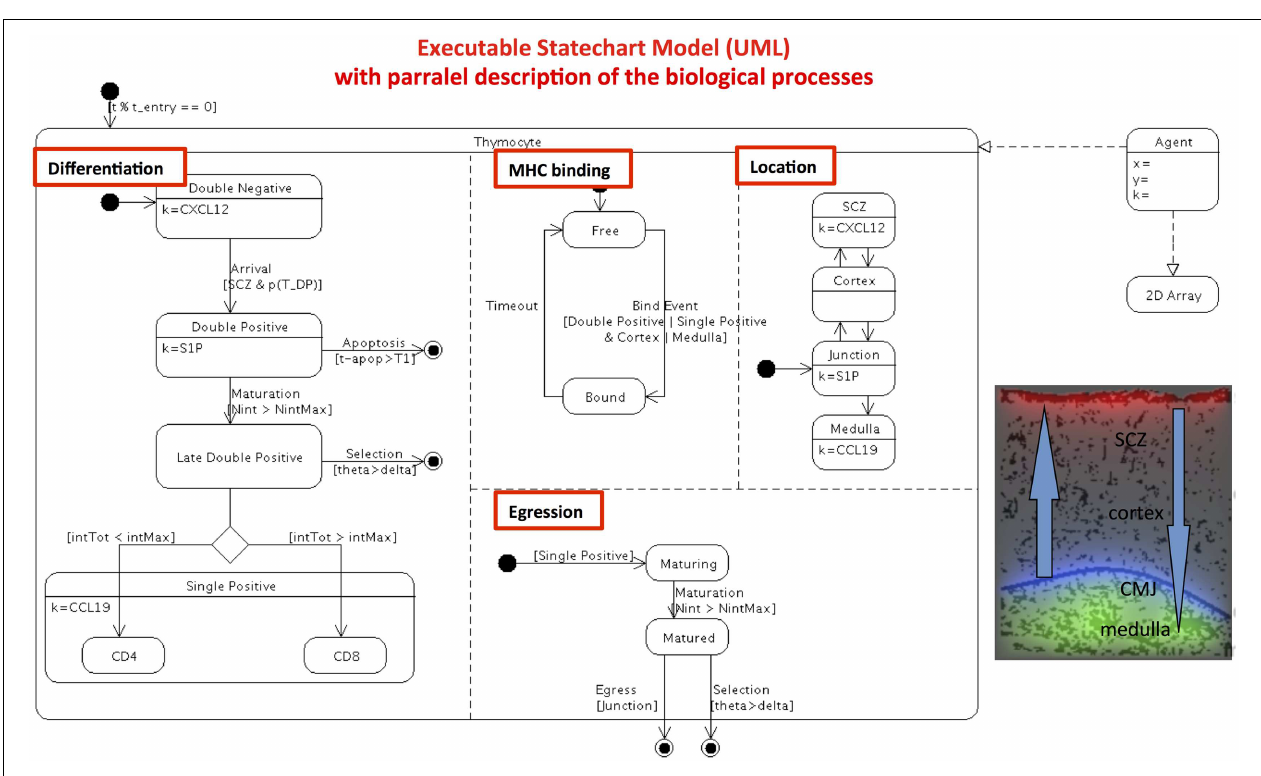
represented by their differentiation from DN to SP stage, sequential binding event ofTCR/MHC peptide on epithelial cells, thymic location, egression of cell when matured. Additional qualitative abstractions for computational model of individual cells in semi-realistic environment are represented by the 2-D array: cells are allowed migrating sequentially through the epithelial cell network (black network) across the various thymic areas, guided by chemokine gradients CXCL12 (red), CCL19/CCL21 (green), S1P